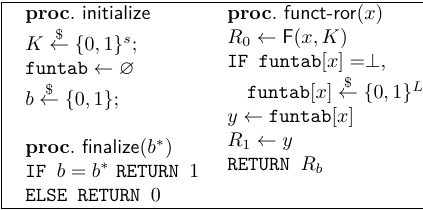
Figure 25: Procedures in Security Game